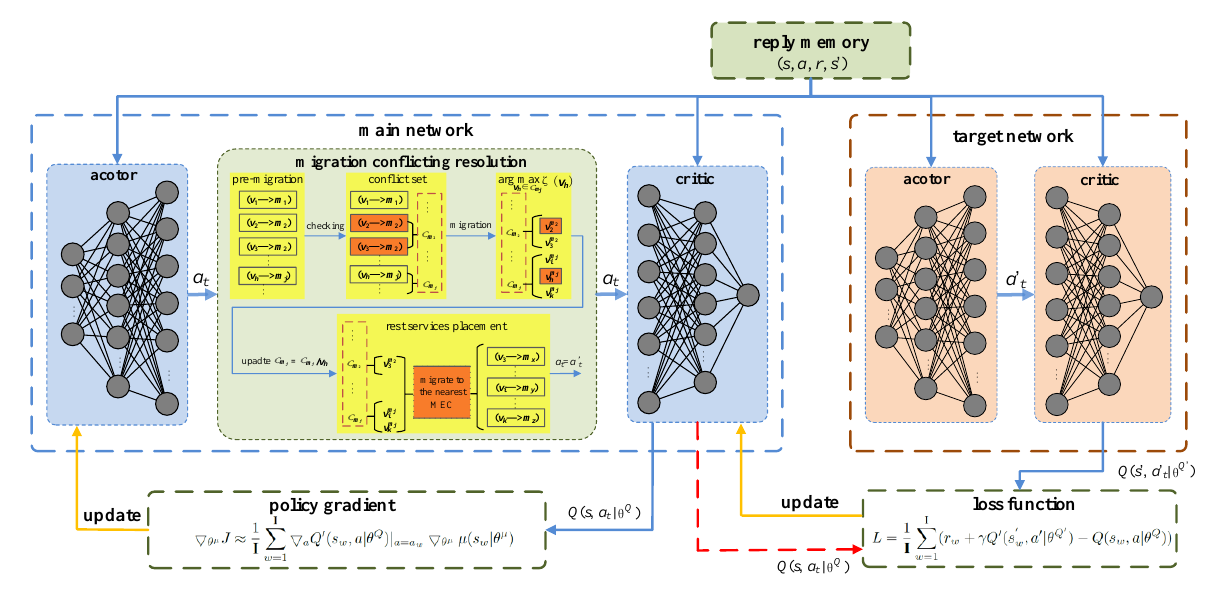
Figure 2. The overview of the DSP-DRL